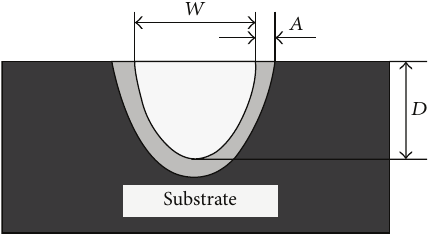
Figure 4: Schematic drawings of cross-sectional bead geometry.